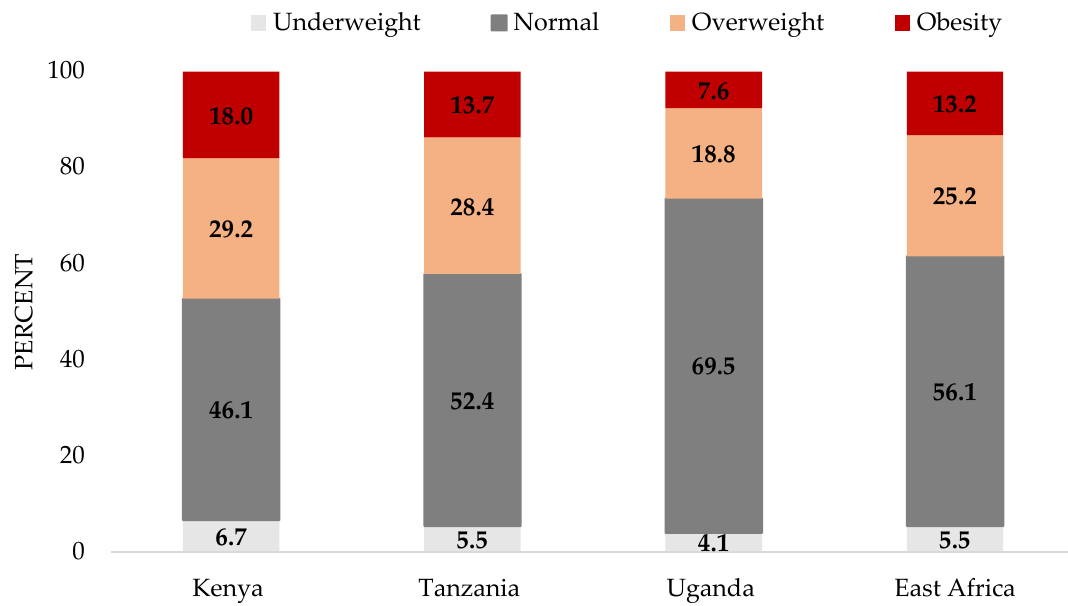
Figure 1. The rate of underweight, normal weight, overweight, and obesity among rural women of reproductive age in Kenya (N = 445), Tanzania (N = 292), Uganda (N = 415), and East Africa (N = 1152).